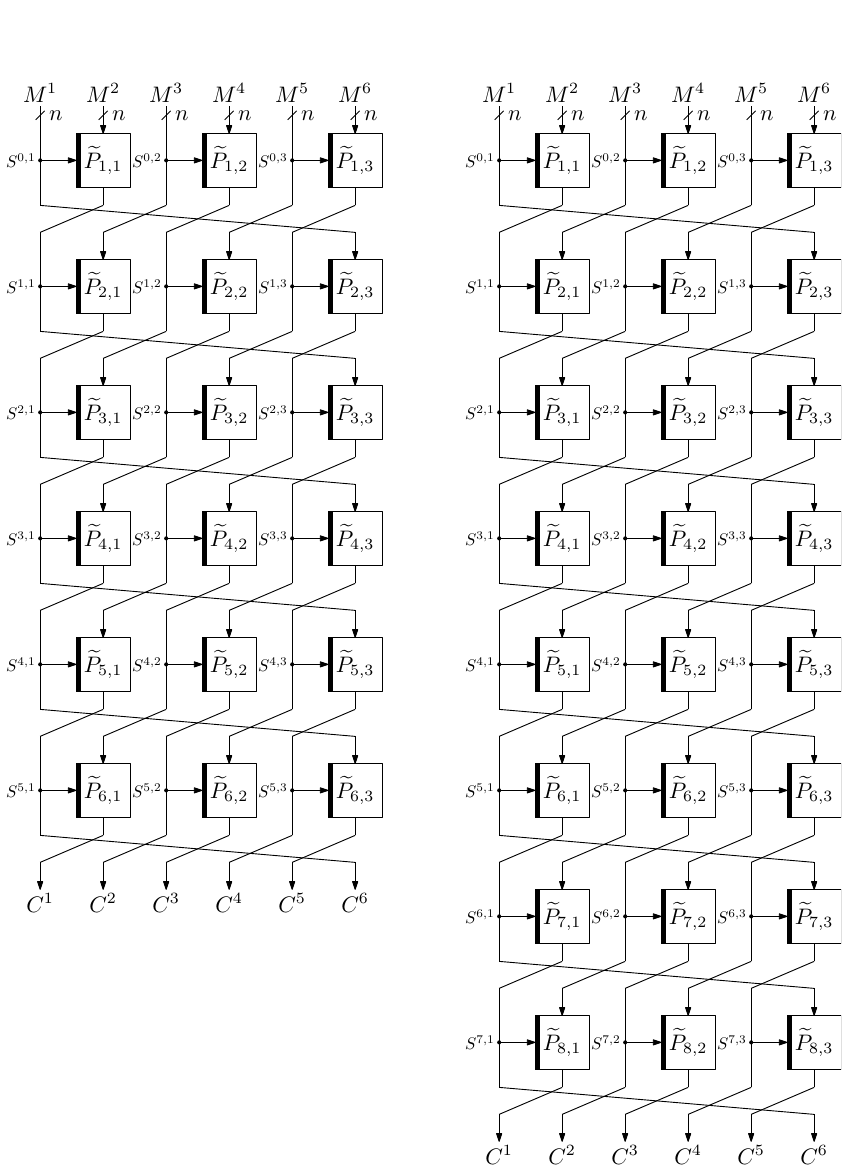
Figure 13: Left: E 2 ,d,r ( M 1 ∥ · · · ∥ M 6 ) = ( C 1 ∥ · · · ∥ C 6 ) for the case d = 6 and r = 6, where ( M 1 ∥ · · · ∥ M 6 ) = ( S 0 , 1 ∥ S − 1 , 2 ∥ S 0 , 2 ∥ S − 1 , 3 ∥ S 0 , 3 ∥ S − 1 , 1 ) and ( C 1 ∥ · · · ∥ C 6 ) = ( S 6 , 1 ∥ S 5 , 2 ∥ S 6 , 2 ∥ S 5 , 3 ∥ S 6 , 3 ∥ S 5 , 1 ). Right: E ( M 1 ∥ · · · ∥ M 6 ) = ( C 1 ∥ · · · ∥ C 6 ) for the 2 ,d,r case d = 6 and r = 8, where ( M 1 ∥ · · · ∥ M 6 ) = ( S 0 , 1 ∥ S − 1 , 2 ∥ S 0 , 2 ∥ S − 1 , 3 ∥ S 0 , 3 ∥ S − 1 , 1 ) and ( C 1 ∥ · · · ∥ C 6 ) = ( S 8 , 1 ∥ S 7 , 2 ∥ S 8 , 2 ∥ S 7 , 3 ∥ S 8 , 3 ∥ S 7 , 1